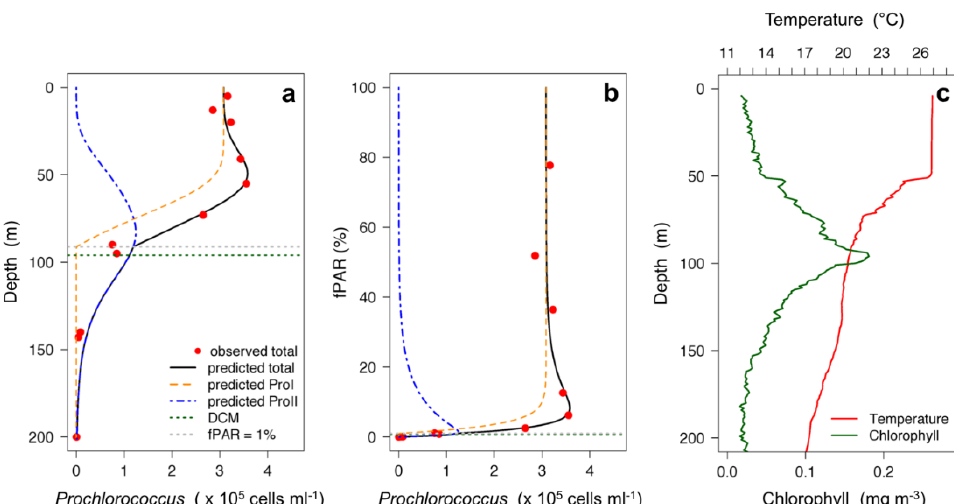
Figure 3. Vertical profiles of observed and estimated Prochlorococcus cell abundances ( a ) over depth and ( b ) over the fractional PAR fPAR , with ( c ) corresponding profiles of temperature and chlorophyll from CTD measurements at a site inside the North Atlantic Gyre (26° N, 50° W). For ( a , b ), in situ observations are represented by red dots, predicted profiles of ProI by the orange dashed line, predicted profiles of ProII by the blue dashed line, and predicted profiles of total Prochlorococcus abundance by the solid black line. Data from AMT 24 (2014).